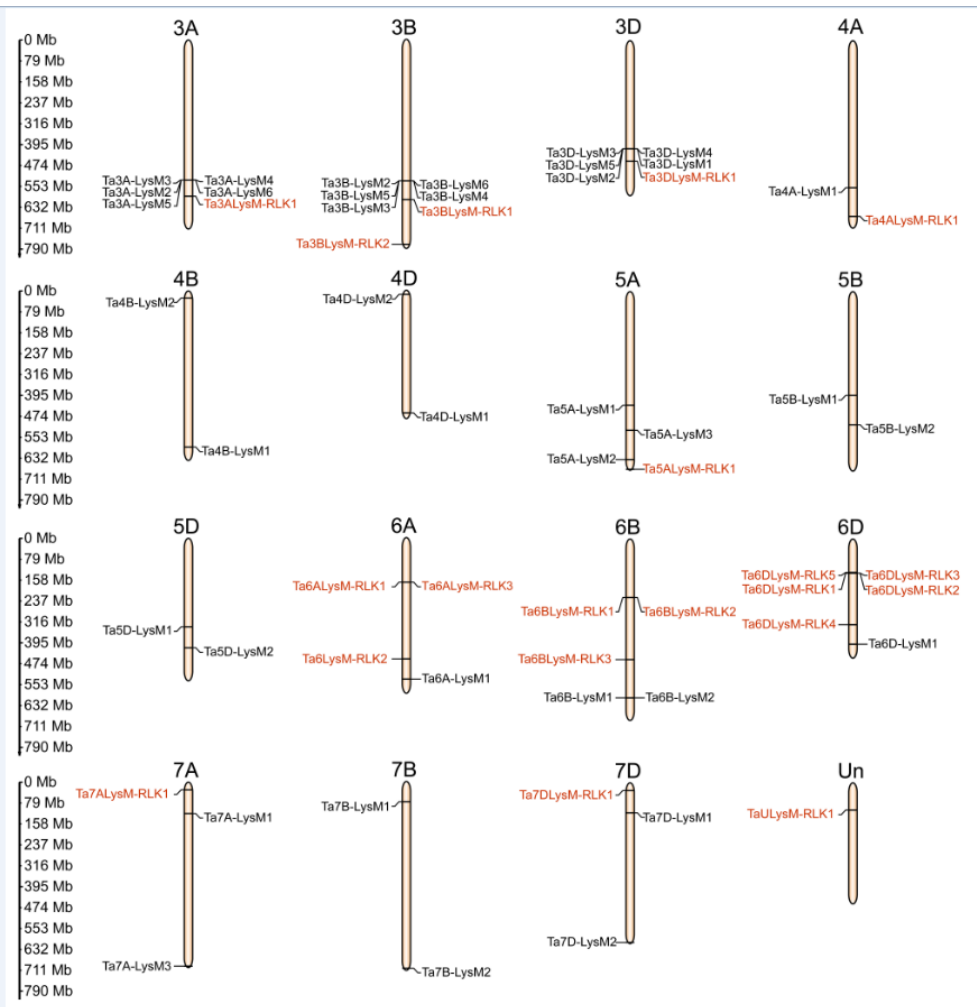
Figure 4. The chromosomal distribution of LYP and LYK genes in wheat. Distribution of LYP genes (black) and LYK genes (red) in the three subgenomes. The numbers at the left represent the length of the chromosomes and also provide the locations of these genes on their chromosomes.